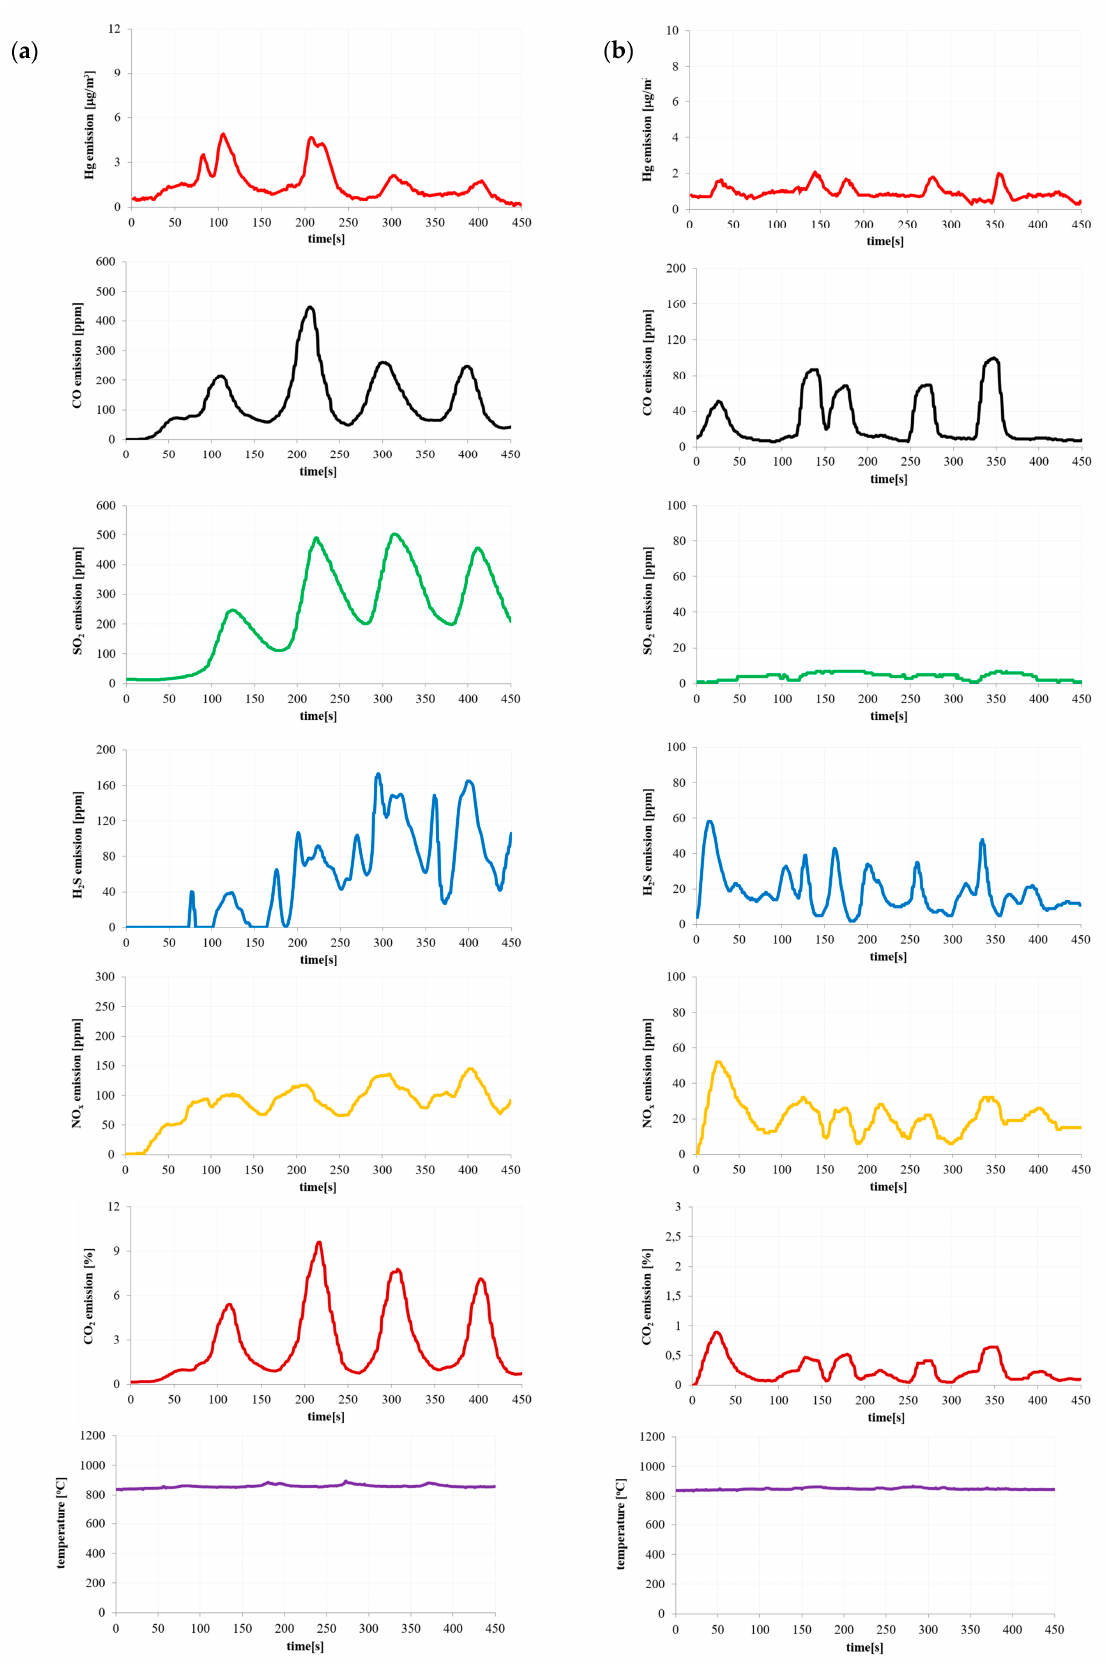
Figure 4. Emission of pollutants during ( a ) paper waste and ( b ) biomass waste combustion.